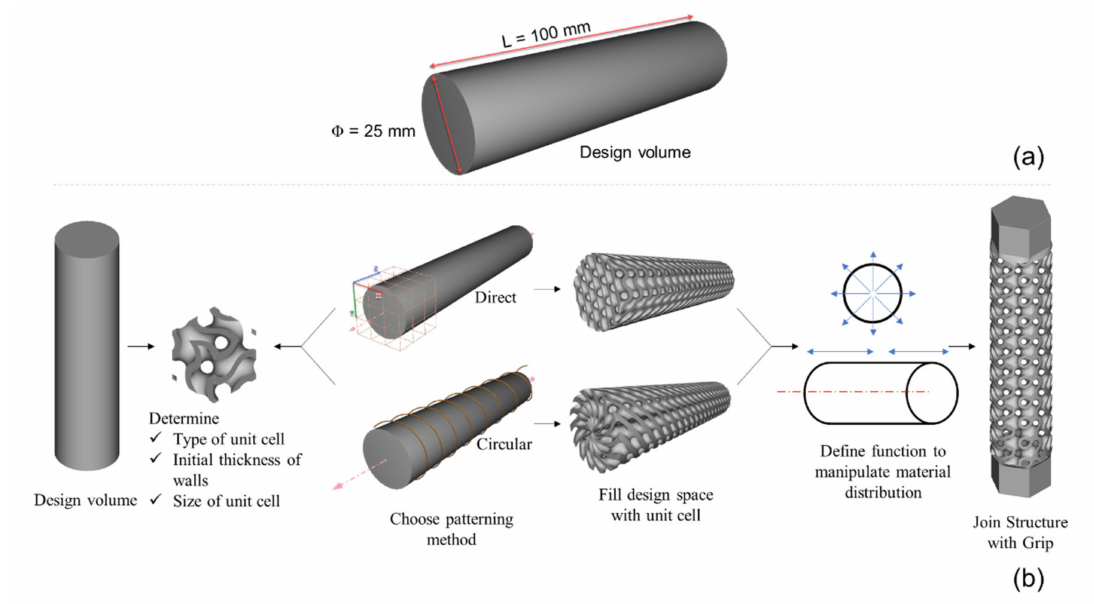
Figure 4. ( a ) Design volume used for all structures, ( b ) Overall procedure used to design functionally gradient lattice